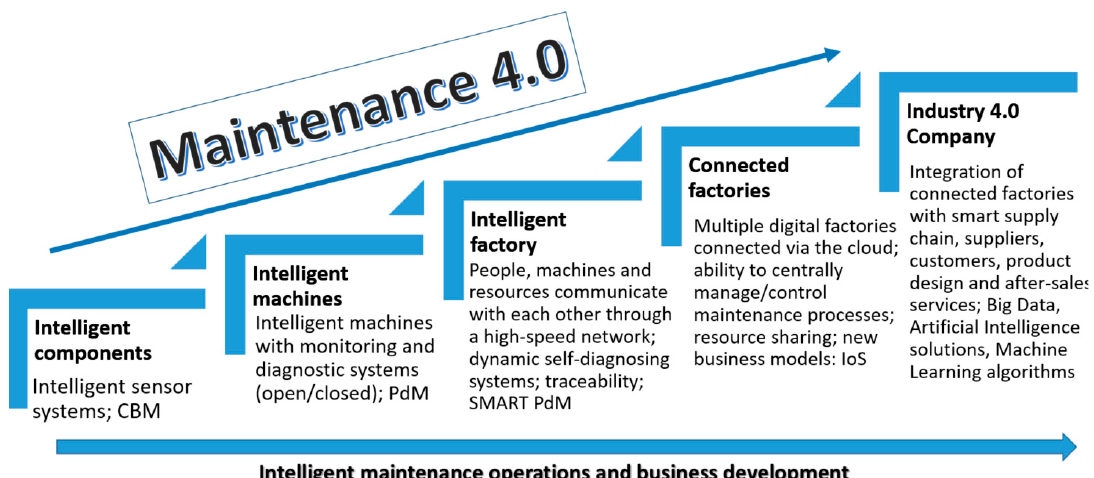
Figure 6. Development directions in Maintenance 4.0. Source: own contribution based on [52].